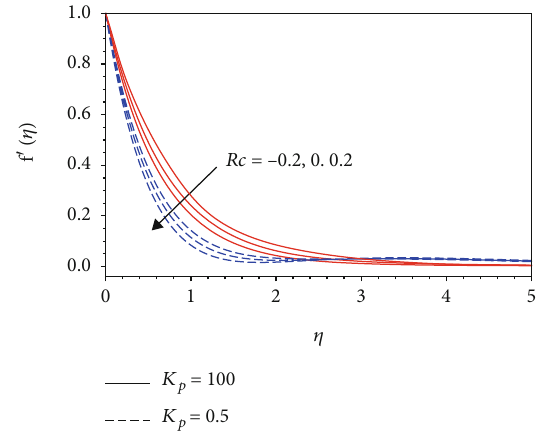
Figure 2: Velocity pro fi les for dissimilar values of Rc when M = 1 and f = 0 . w